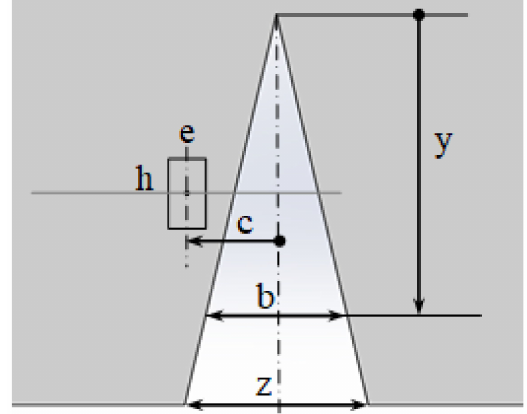
Figure 26. Crack geometry. The results were processed in 3 nested